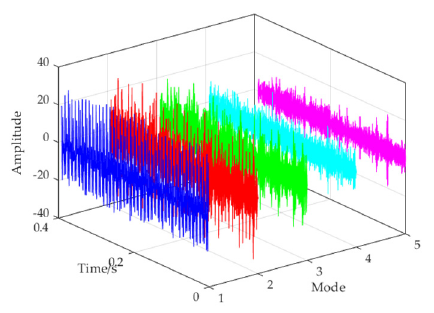
( b ) Figure 15. Outer ring fault signal. ( a ) Time-domain waveform using CLNGO-MNAD. ( b ) Envelope spectrum of using CLNGO-MNAD. 5.2.3. Composite Fault (Inner Ring and Outer Ring Damage) Bearing 1_5 late fault data were selected, and the bearing speed was , 107.9 o f Hz = and